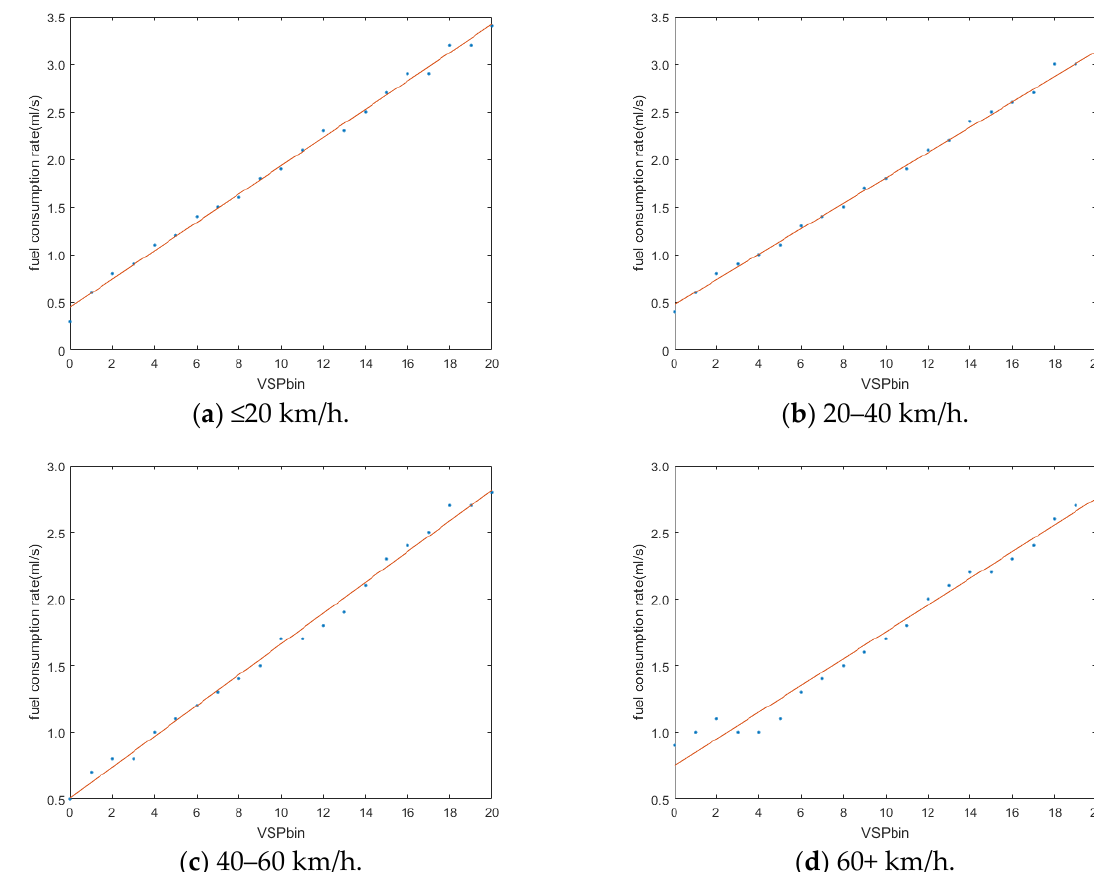
Figure 6. The regression results after the cluster analysis of the VSP bin.